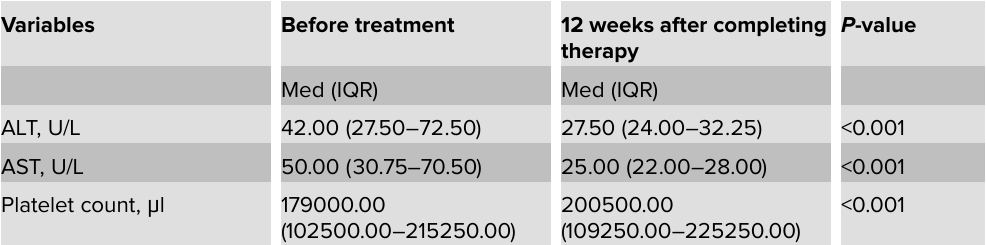
TABLE 2: Comparison of ALT, AST, platelet count, and liver stiffness index before and after treatment in patients with chronic hepatitis